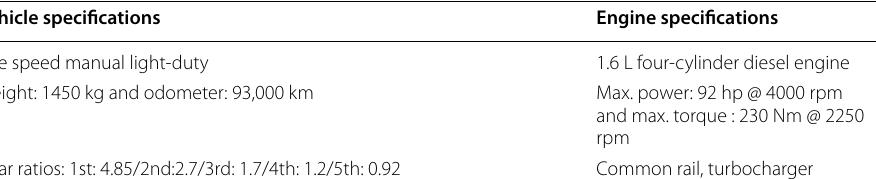
Table 3 Specifications of the test vehicle Vehicle specifications